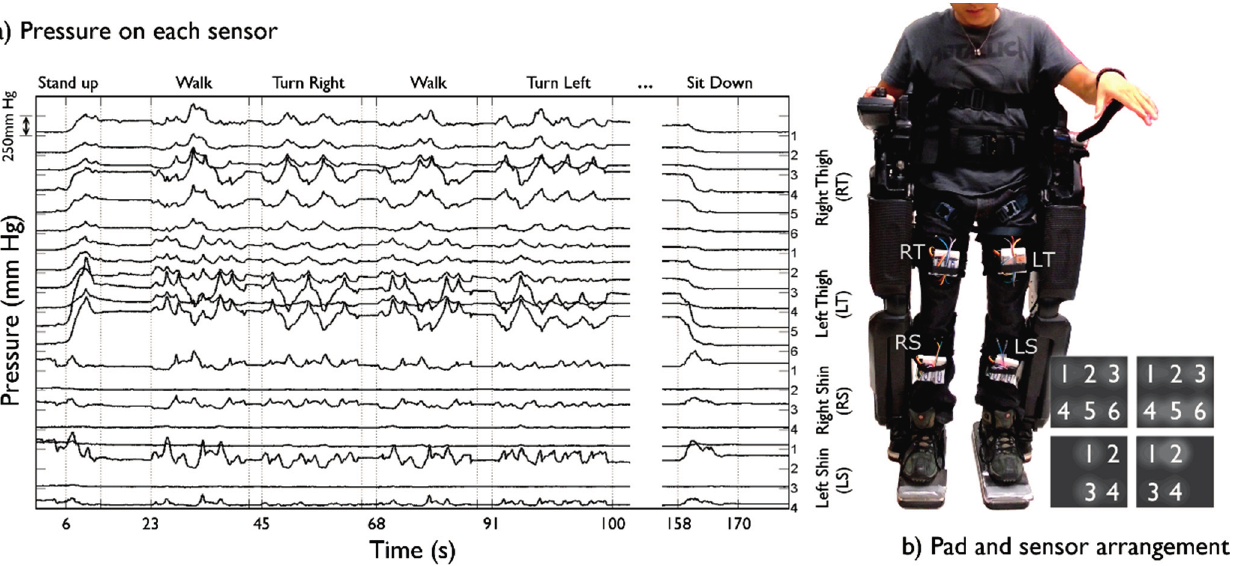
Figure 4. Pressure measurements of one SCI subject performing locomotion and non-locomotion tasks using a powered exoskeleton. ( a ) Twenty sensors arranged in 4 measuring pads (RT, RS, LT, LS). One trial including “stand up”, “walk”, “turn right”, “turn left” and “sit down” tasks. LT sensors 5 and 6 consistently show greater pressure levels, suggesting the lower strap of the subject’s left thigh was adjusted tighter with the outer part receiving more force; ( b ) Rehab Rex exoskeleton from Rex Bionics is shown. Six sensors are used on thigh pads; 4 on shin pads. Shin sensors are positioned over risk areas caused by bony prominences corresponding to the